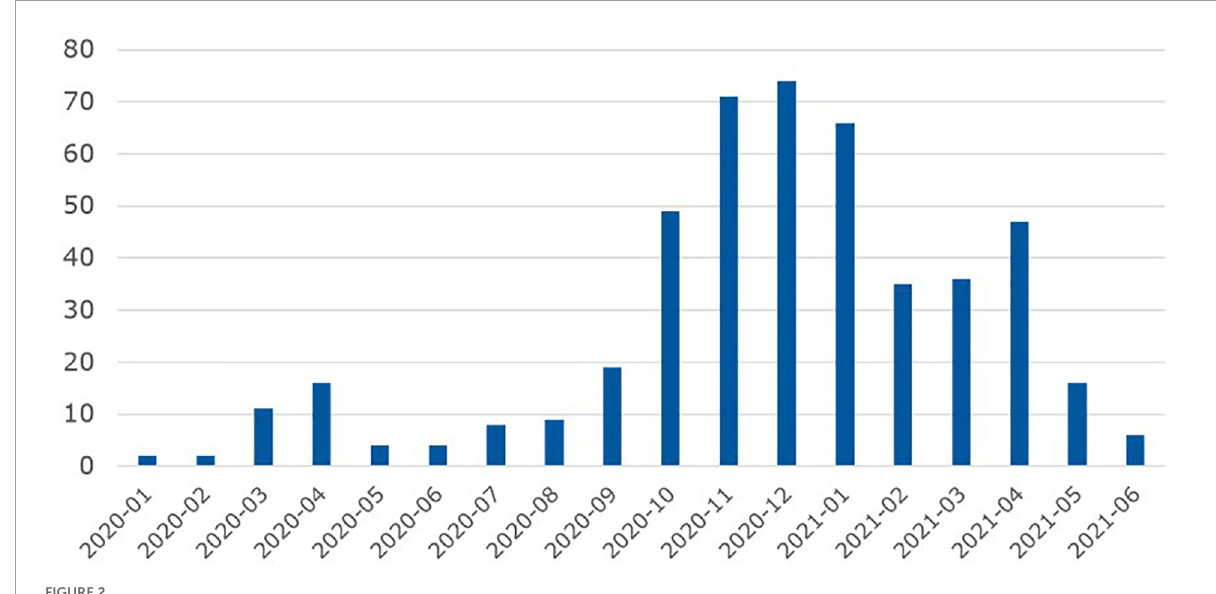
FIGURE2 Monthly case numbers of COVID-19 among psychiatric inpatients of the nine psychiatric LVR-hospitals. Observation period: 1 January 2020 until 30 June 2021.